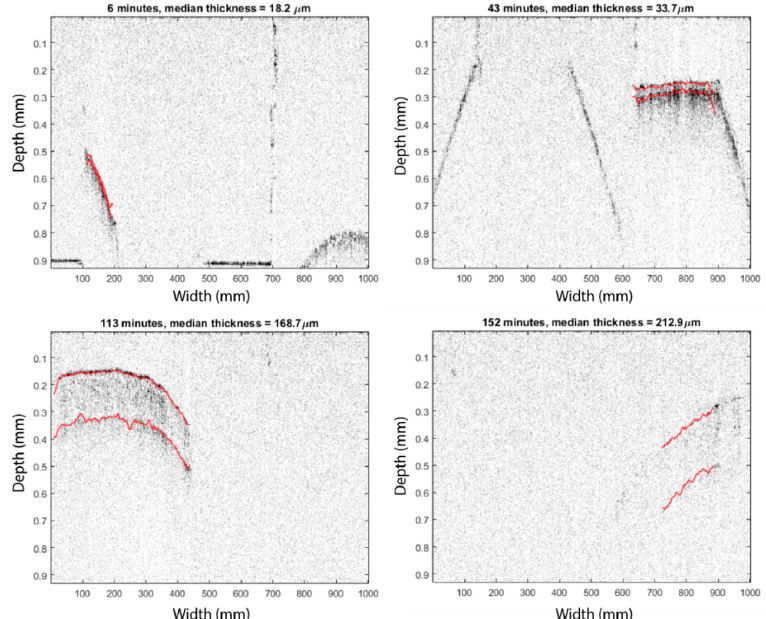
Figure 5. B-scans captured with SD-OCT at an in-line setting for a lab-scale tablet coating process showing the measured tablets with highlighted coating interfaces using segmentation algorithm as part of automated thickness quantification. The title of each OCT image indicates the mean calculated from the detected coating layer interfaces. The x -axis represents the width of the tablet measured and depends on the tablet movement speed. Adapted from